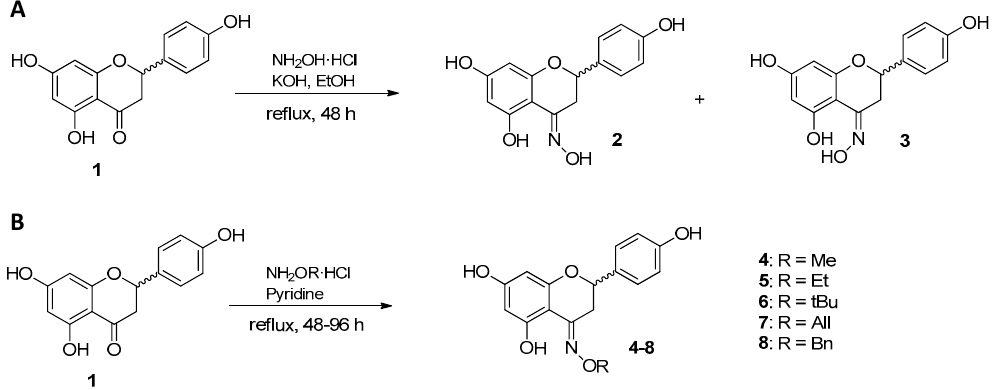
Figure 1. Synthesis of naringenin oximes ( 2 and 3 ) ( A ) and oxime ethers ( 4 – 8 ) ( B ) .